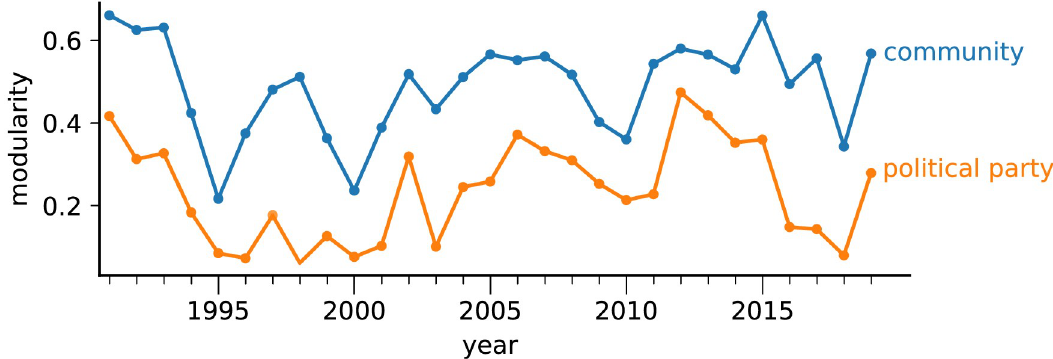
Fig 7. Evolution of the modularity measurement. To compute the modularity, we considered the groups obtained via community detection method (blue curve) and the organization of deputies in political parties (orange curve).